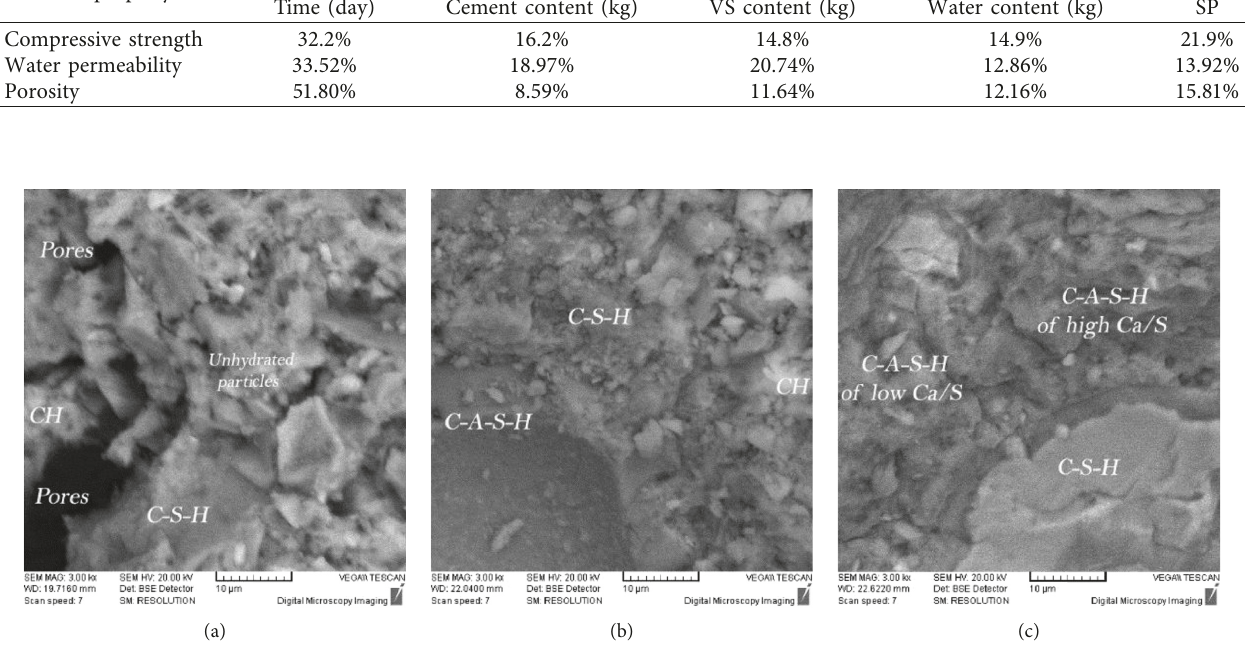
Figure 18: SEM of (a) 7 day-cured VS30-based paste, (b) 28 day-cured VS30-based paste, and (c) 90 day-cured VS30-based paste.